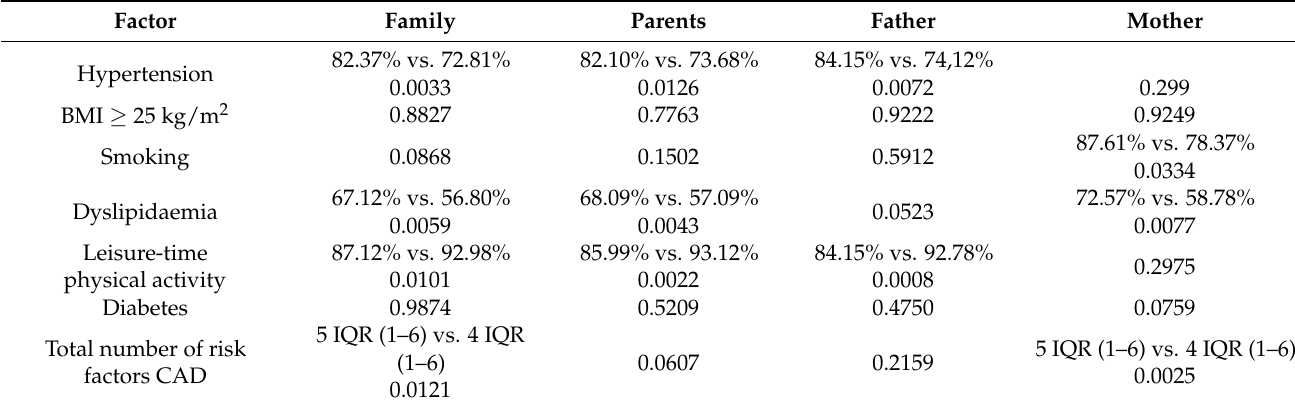
Table 4. Relationships between risk factors for erectile dysfunction and the occurrence of CAD in the family, parents, father, and